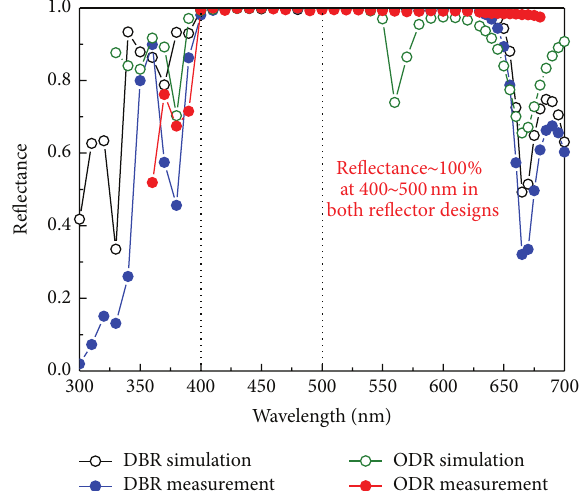
Figure 2: The reflectance in measurement results and simulation data between distributed Bragg reflector (DBR) and omnidirectional reflector